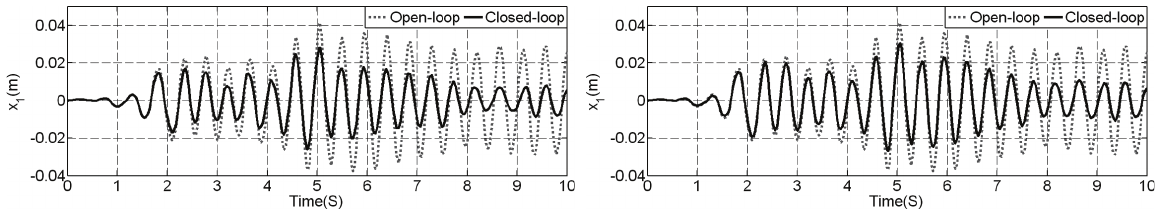
Fig. 4. Displacements of the first storey in case A3 ( τ = 25 ms). Fig. 5. Displacements of the first storey in case A4 ( τ = 25